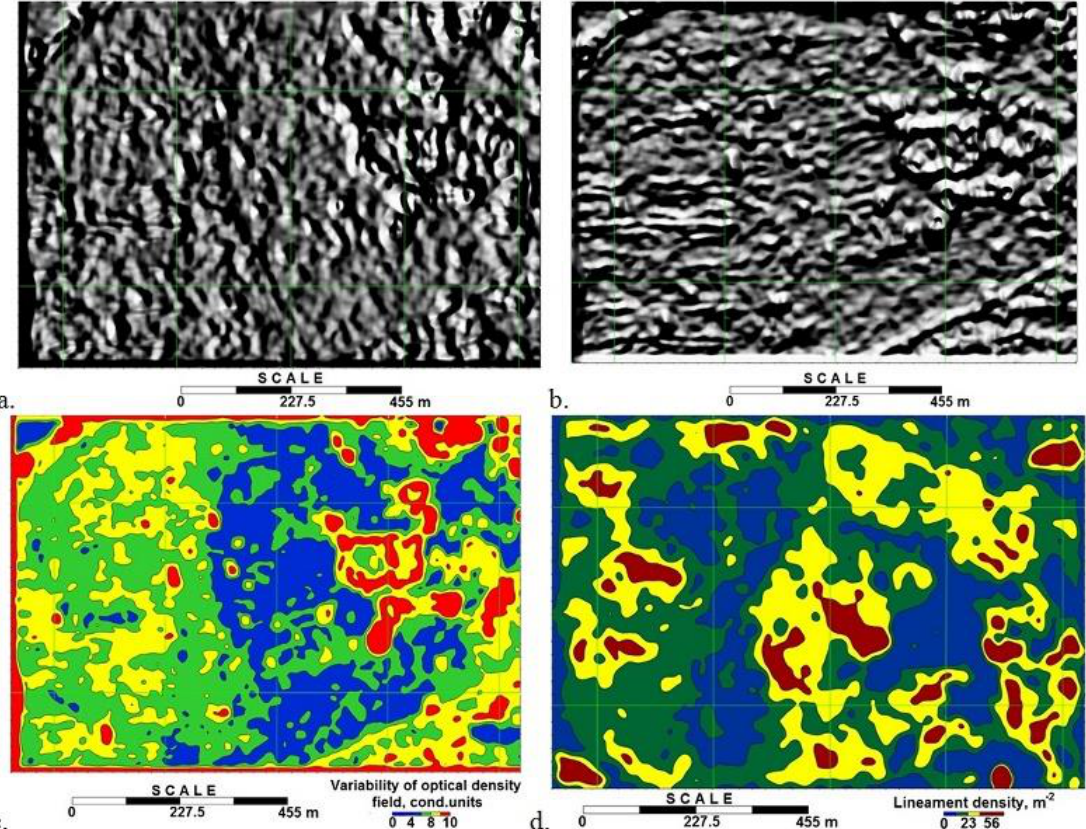
Figure 2. The example of recalculation of remote sensing data and digital elevation model into a form which clearly demonstrates the position and orientation of linear (geodynamic) zones: ( a , b ) the result of applying differential operators to digital elevation models for contrasting the positions of geodynamic zones of different strike azimuths (northwest and northeast, respectively); ( c ) characterization of the degree of disorder (entropy) of the optical density field of the considered area; ( d ) field of lineaments density (the degree of fragmentation in the upper part of the cross-section) of the survey area (Shchekinsk area, Tula region). One can see the ways of tracing linear geodynamic zones which verifies the results of automated lineament analysis.